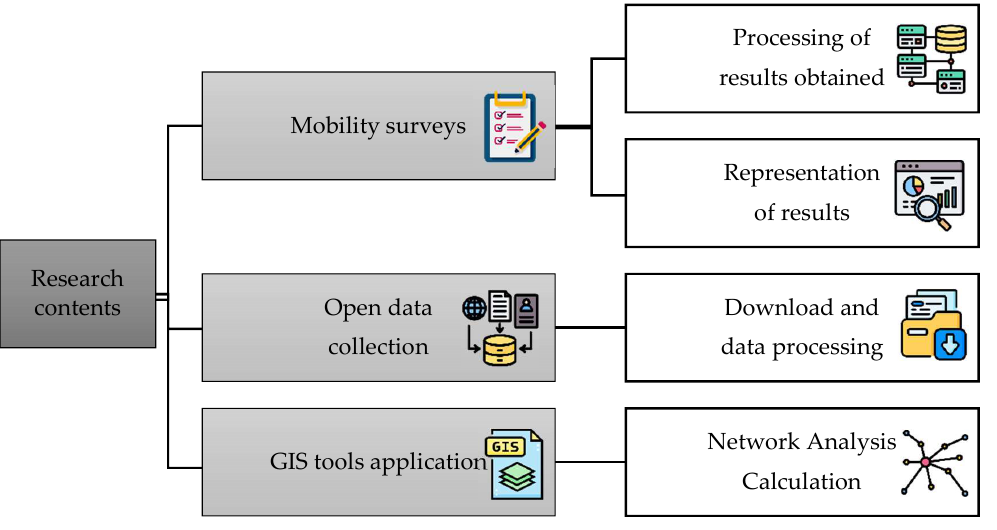
Figure 1. Methodology